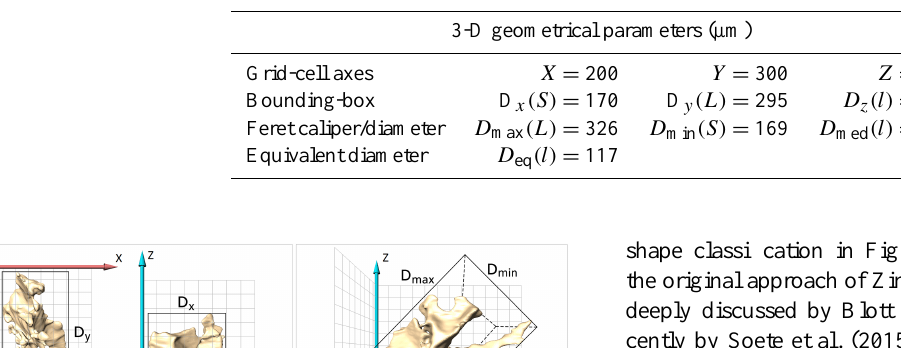
Table 1. 3-D geometrical parameters of the detached particle from the main pore network of rock S 1 in the 250 3 voxel volume, as shown in Fig. 1.